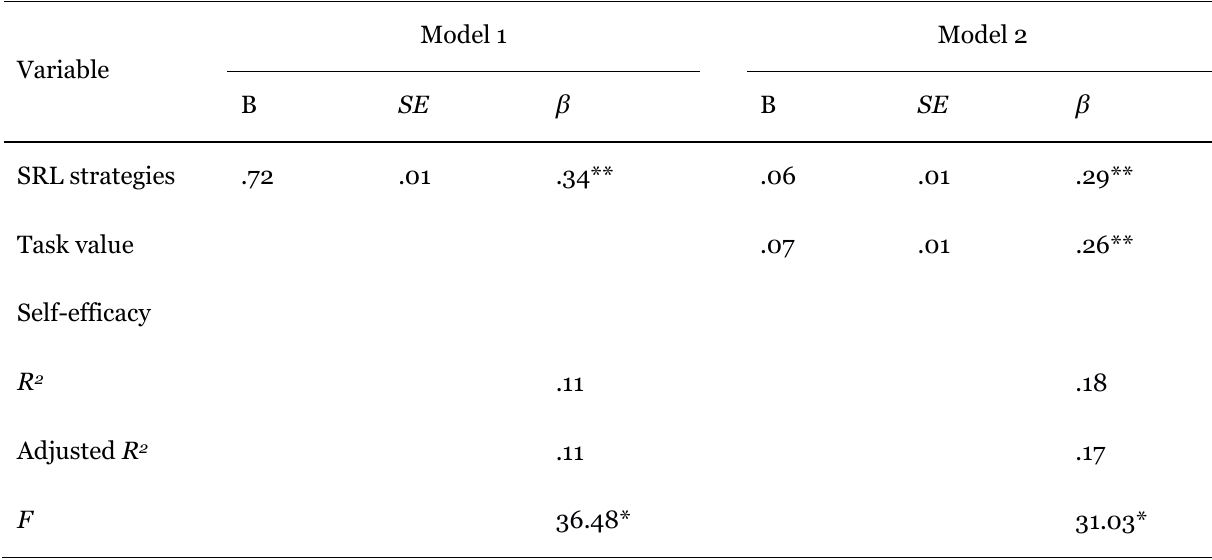
Results of Stepwise Multiple Regression